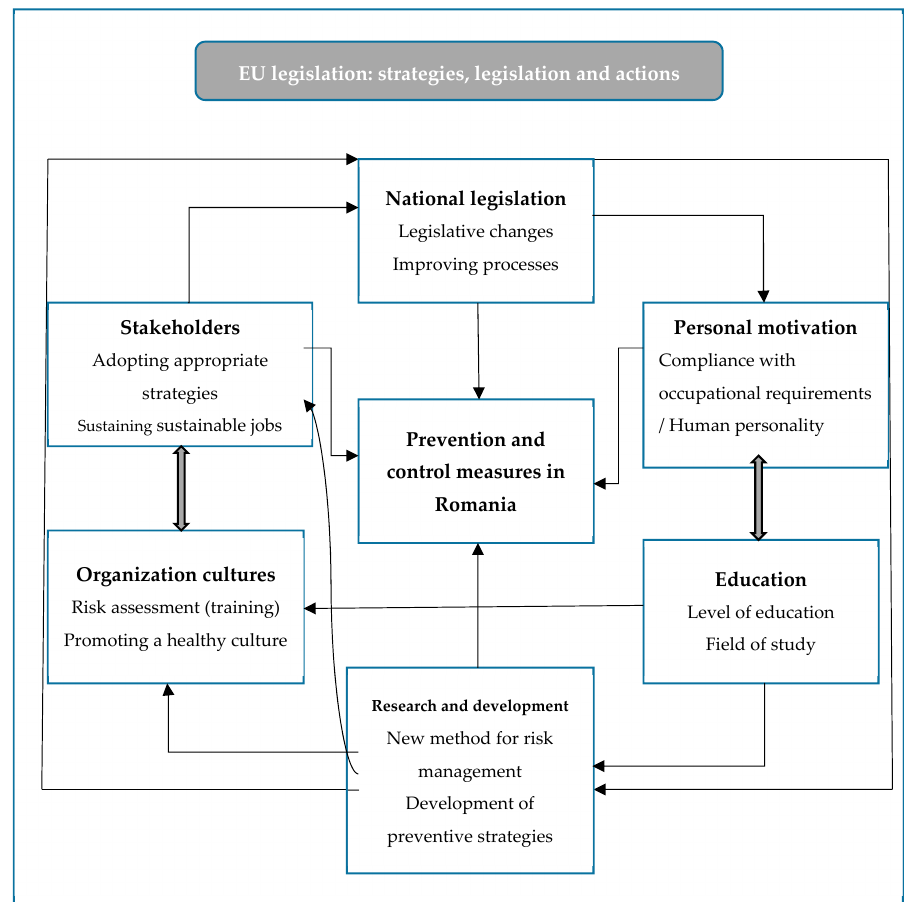
Figure 18. Investigation model for prevention and control.